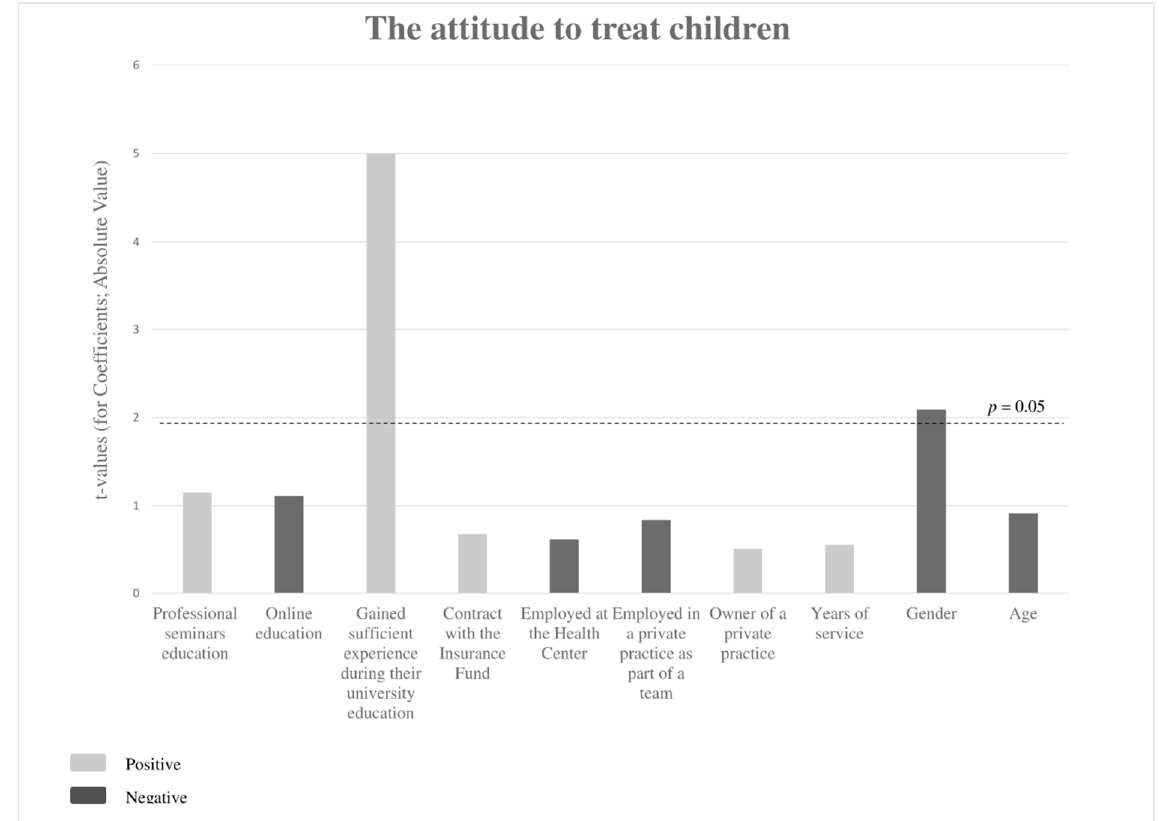
Figure 2. The dependence of the attitude to treat children based on prediction variables. The results of the linear regression analysis.